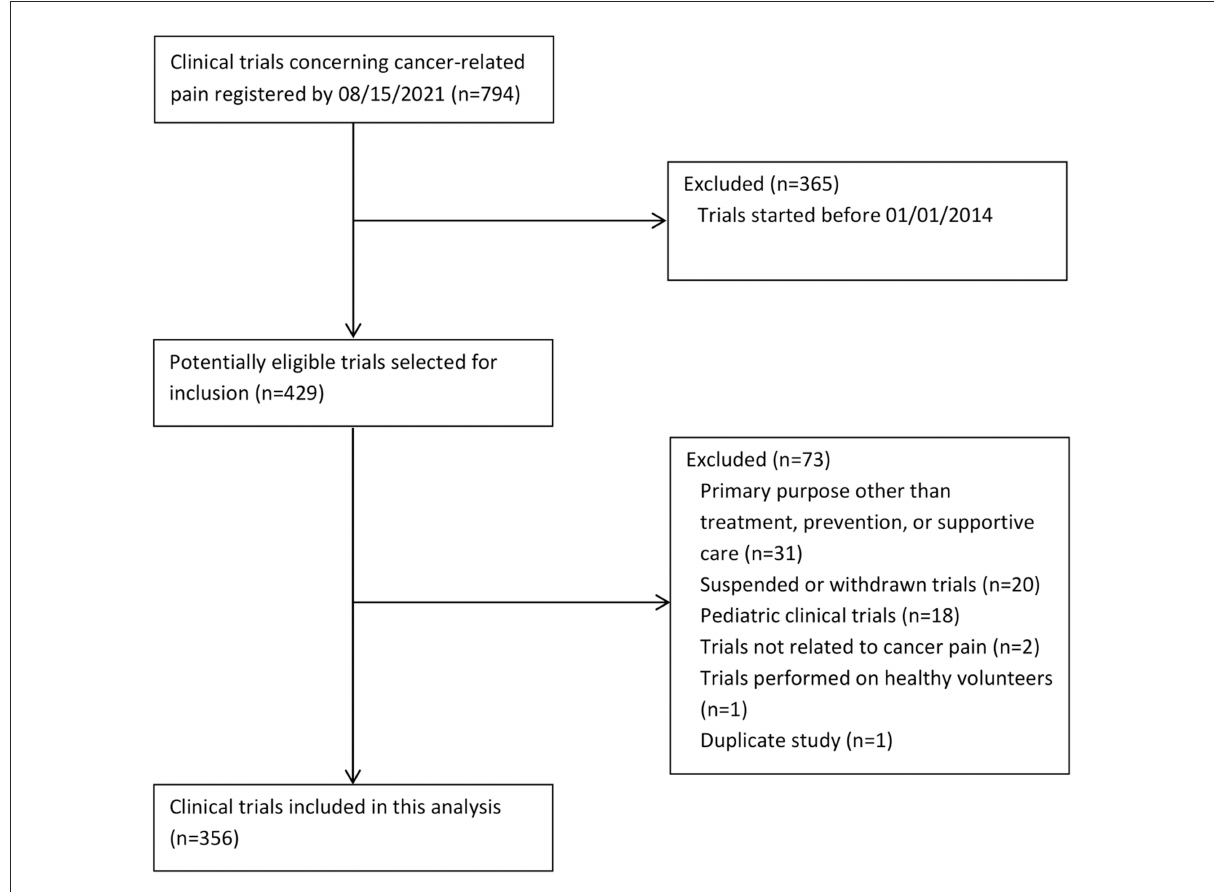
FIGURE1 Selection of eligible clinical trials concerning cancer-related